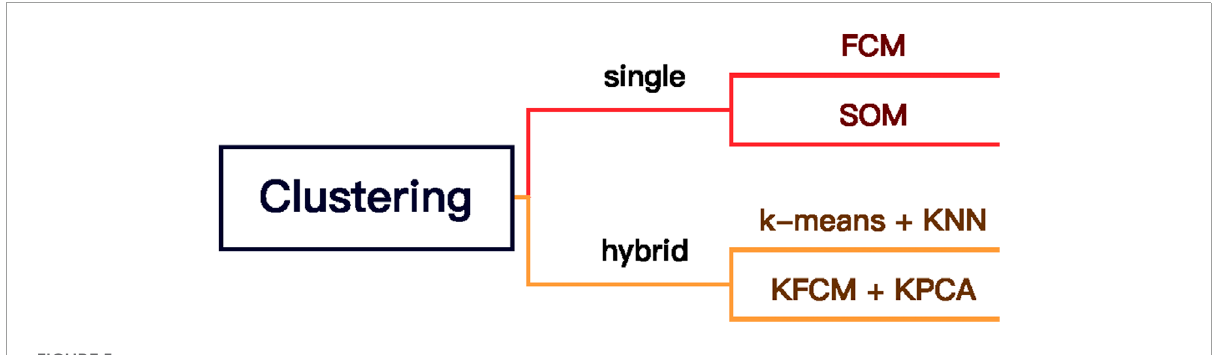
FIGURE 5 Clustering methods for fault